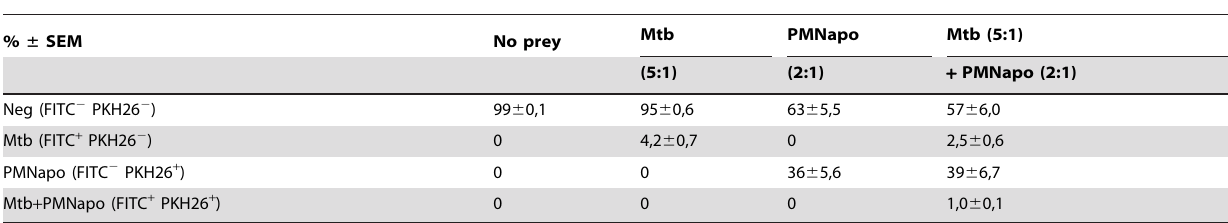
hMDMs were stimulated with FITC labeled c -irr Mtb with or without subsequent stimulation with PKH26-labeled PMNapo. The uptake of Mtb and PMNapo was analyzed by flow cytometry. Values represent percentage of positive cells 6 SEM (n=5).